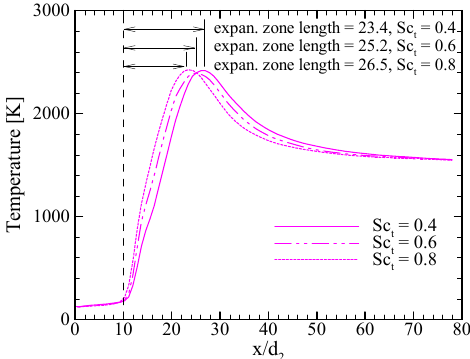
Figure 14. Time-averaged temperature profiles along central-axis for different turbulent Schmidt numbers.